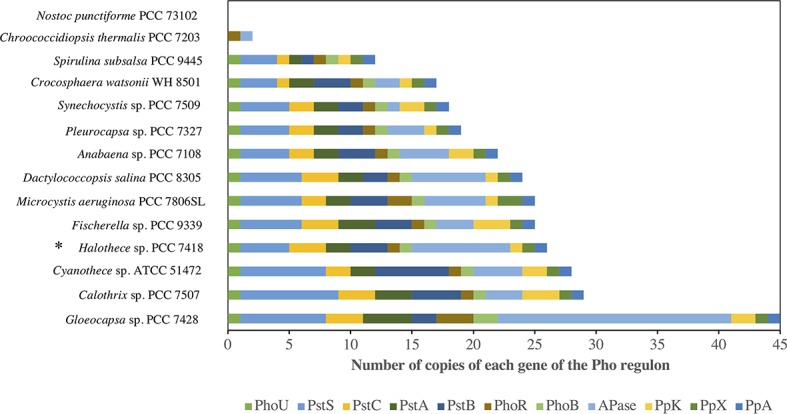
Distribution of the Pho regulon in Halothece sp. PCC 7418 (*) and genomes of its closest cyanobacterial relatives. Annotated genes were identified in PATRIC.